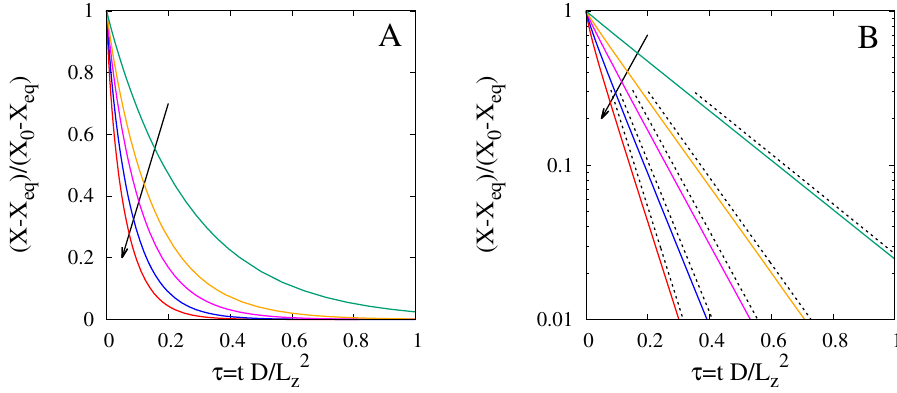
Figure 4. ( A ) Moisture ratio ( X − X eq ) / ( X 0 − X eq ) vs. dimensionless time τ = tD / L 2 z for Bi m = = φ shell = φ = 0.5. ( B ) Log-normal plot of 1,2,3,5,9 and a uniform initial water distribution φ core 0 0 0 dehydration curves reported in Figure ( A ). Arrows indicate increasing values of Bi m . Dashed black lines show the asymptotic theoretical exponential behaviour, Equations (17) and (18). Table 2. Values of γ 0 for R eq / L r = 0.7 and different values of Bi m . Bi m = 1 Bi m = 2 Bi m = 3 Bi m = 5 Bi m = 7 Bi m = 9 γ 0 1.35252 1.79058 2.06105 2.38064 2.56061